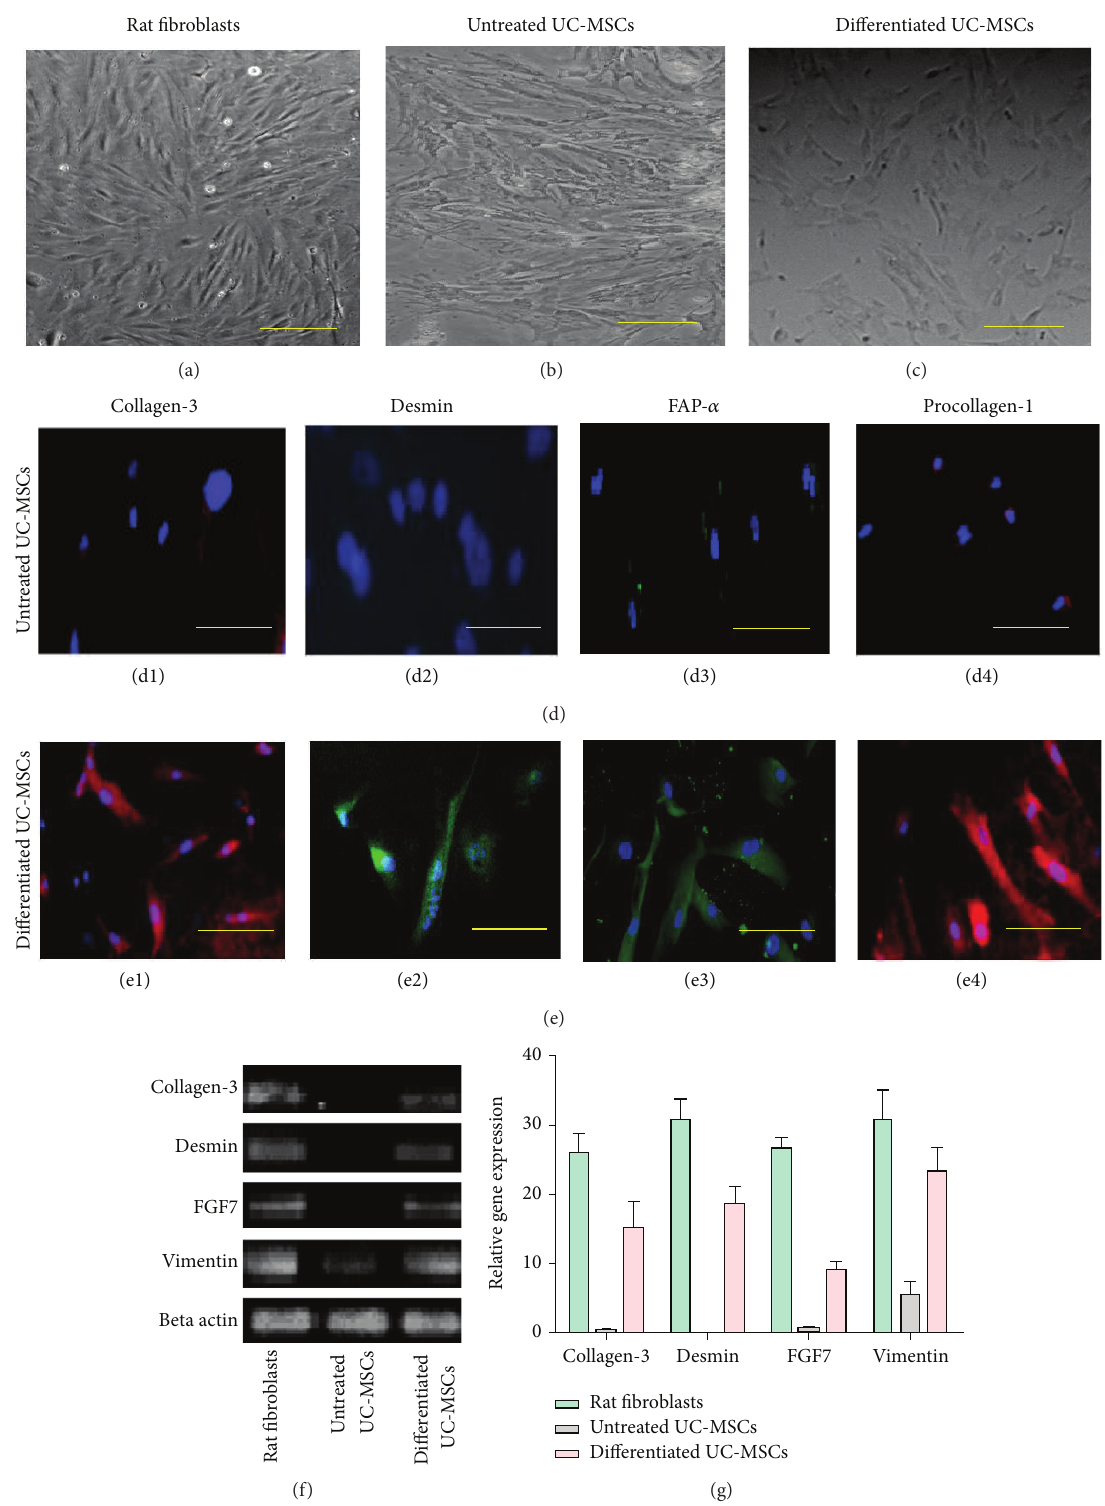
Figure 5: Differentiation potential of cord tissue derived UC-MSCs into dermal fibroblast-like cells. Cytomorphology of (a) positive control, (b) untreated UC-MSCs, and (c) induced dermal fibroblast-like cells. Immunofluorescence staining with collagen-3, desmin, FAP- 𝛼 , and procollagen-1 in ((d1)–(d4)) untreated UC-MSCs and in ((e1)–(e4)) induced cells. Expression of mRNA of collagen-3, desmin, FGF7, and vimentin has been shown in (f). Expression of these genes was significantly upregulated in induced cells as compared to untreated cells. Collagen-3: collagen type 3, FGF7: fibroblast growth factor 7, FAP- 𝛼 : fibroblast activation protein-alpha, and procollagen-1: procollagen type 1. (g) showed graphical representation of RT-PCR